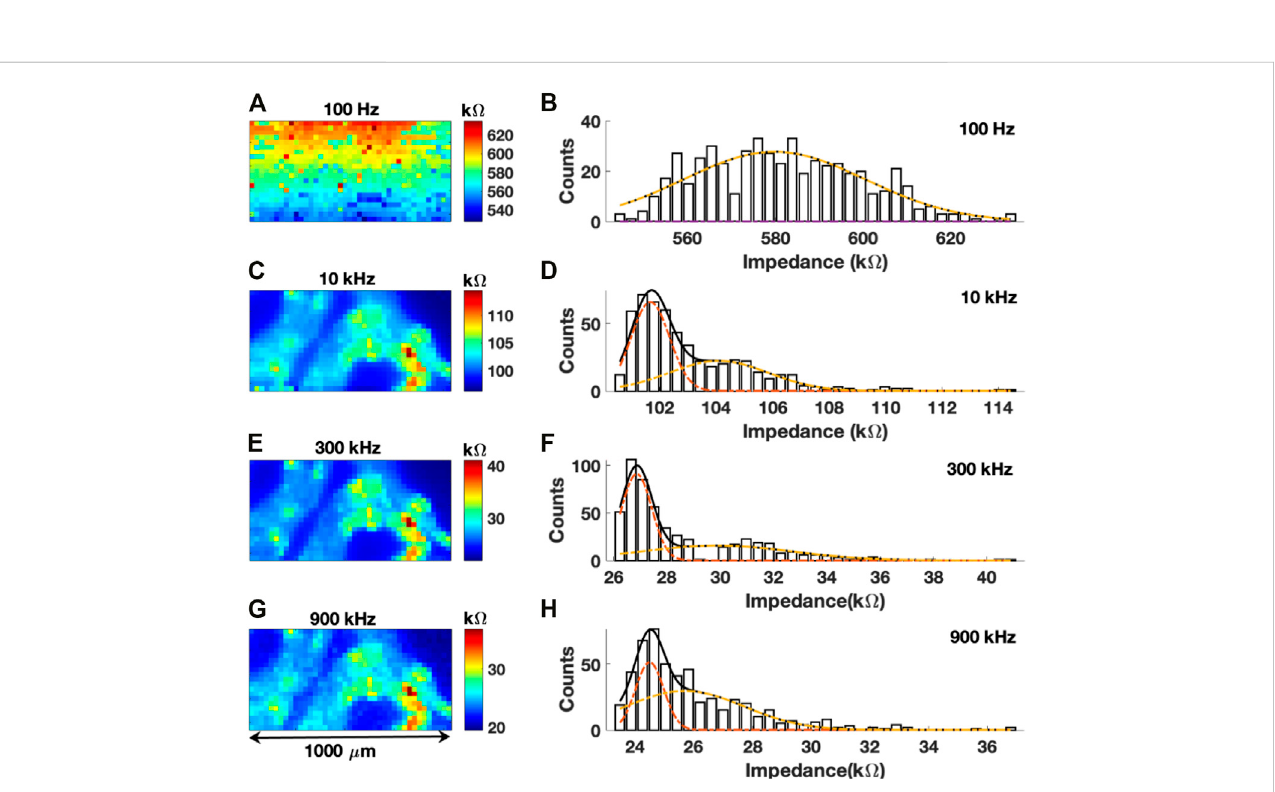
FIGURE 4 (A,C,E,G) Impedance map of colon sections at frequencies of 100 Hz, 10 kHz, 300 kHz, and 900 kHz, respectively. (B,D,F,H) Histogram of impedance values with a Gaussian fi t for 100 Hz, 10 kHz, 300 kHz, and 900 kHz scans,